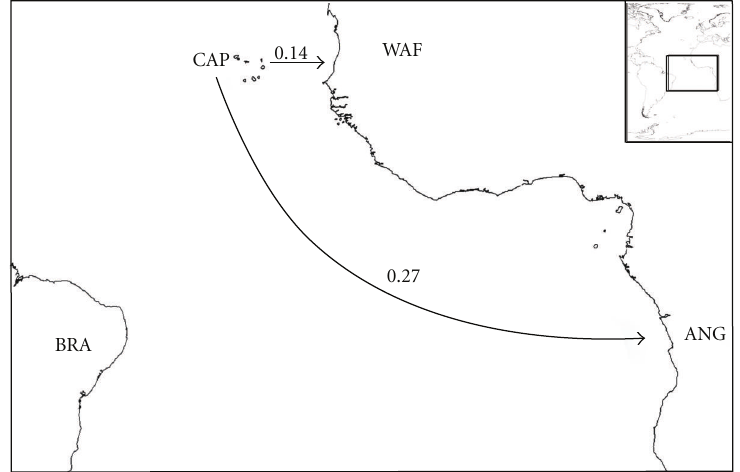
Figure 8: Probable colonization patterns of rissoid fauna in the Central East-Atlantic. The arrows represent the probable main flux direction of faunas, and the associated numbers represent, for each pair of areas, the higher of the two similarity index values computed as described in the methods, abbreviations as in Table